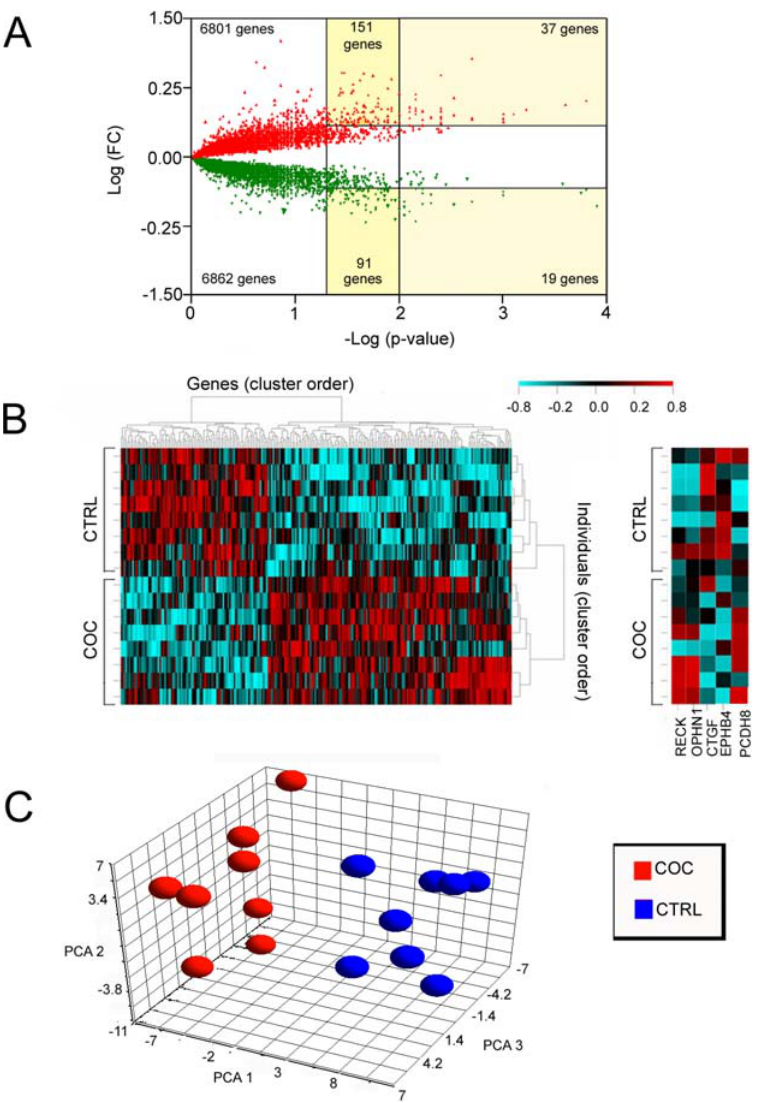
Figure 1. Gene expression in the human hippocampus for cocaine abusers and control subjects. A, Volcano plot illustrating the total number of genes (13,662) meeting the criterion ( $ 75% present call). For all genes detected on the Affymetrix Human Genome HGU133 A & B Chip Set, each point represents a gene plotted as a function of fold-change (Log (fold change), y-axis) and statistical significance (-Log ( p -value), x-axis). Vertical lines represent p values of 0.05 and 0.01, respectively. The upper and lower horizontal lines represent fold changes of + 1.3 and 2 1.3, respectively. Green represents downregulation, while red illustrates upregulation in group comparisons. B, Clustered Image Map (left panel) of the relative change in gene expression between the control and cocaine exposure groups. The color change reflects relative change according to the scale shown; red indicates positive fold change and blue indicates negative fold change. B) Representative genes (left panel): RECK, OPHN1, CTGF, EPHB4 and PCDH8 (from left to right). C, Principal Components Analysis (PCA) reveals separation between groups for the 242 differentially expressed genes. Red represents the cocaine abusers (COC, n=8) and blue illustrates the control subjects (CTRL, n=8).